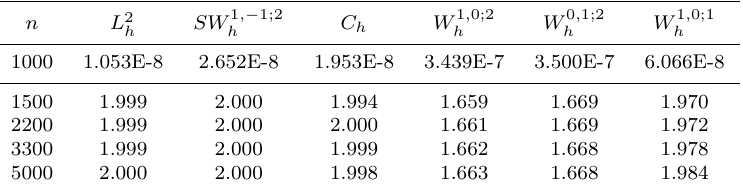
Table 23. Practical errors and error orders in Example C 3 / 2 ,